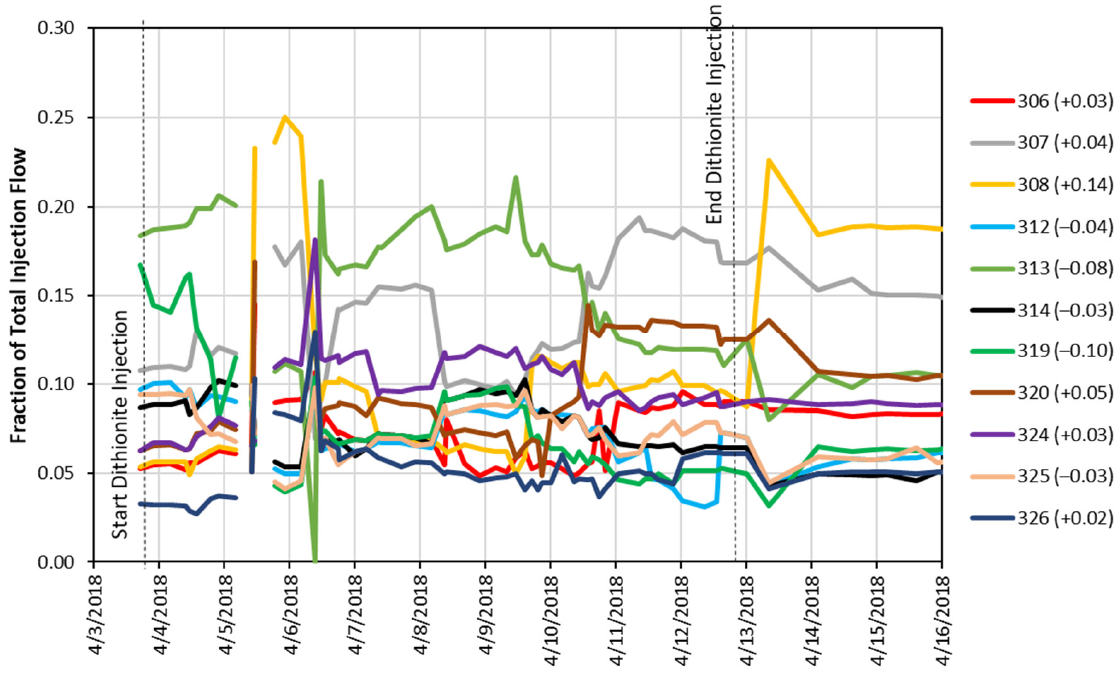
Figure A14. Fractions of total injection flow going into each injection well during the same time period as in Figure A13. Values in parentheses are the changes in fraction of flow for each well from the start of the test (when flows were balanced) to when flows were stabilized at the end of the dithionite injection.